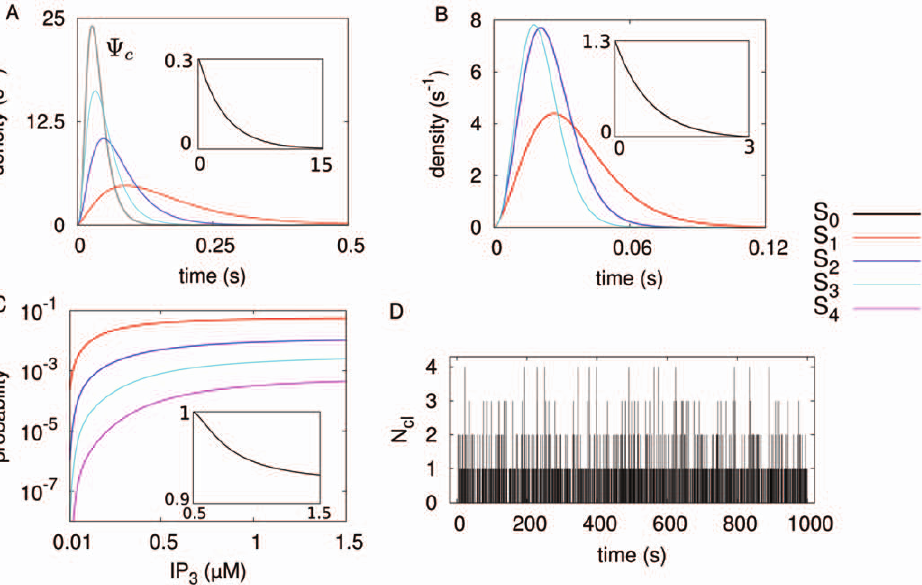
Figure 3. Minimal hierarchic stochastic model of Ca 2 z dynamics. The colours in (A,B,C) depict the system state in terms of the number of open clusters ( S i , i=0,1,2,3,4). (A) Individual opening time ( Y o , i ) and closing time ( Y c ) probability densities. (B) Conditioned waiting time densities for the consecutive opening transitions, constructed out of the individual closing ( y c ) and opening ( y o , i ) densities for the tetrahedron model. Note the time-scale difference between the opening of the first cluster ( Y 01 ) and the consecutive openings, this effectively covers the CICR mechanism. (C) Stationary probabilities for the possible states of the system as function of the cytosolic IP 3 concentration, as computed from Eq. 14. (D) Stochastic simulations of spike trains for ½ IP 3 (cid:2) =1 m M . Note the frequent puff events with less than four clusters open and the rather isolated global spike events. The number of channels per cluster is N ch =5. All calculations are based on the analytic approximations of parameter dependencies shown in Fig. 2.